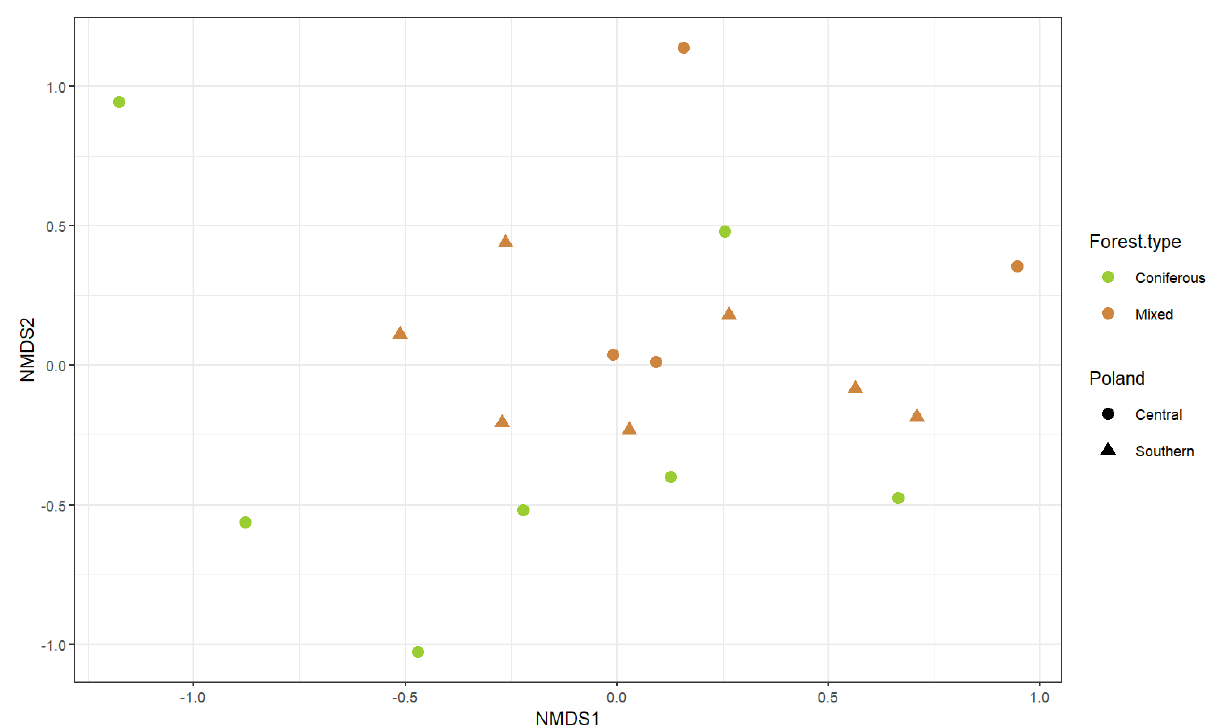
Figure 4. Non − metric multidimensional scaling (NMDS) ordination plot showing fungal communities (numbers of morphotypes within each genus); 2D stress = 0.15. Colors indicate forest type and shapes indicate geographical localization in which the sampled mounds were located.